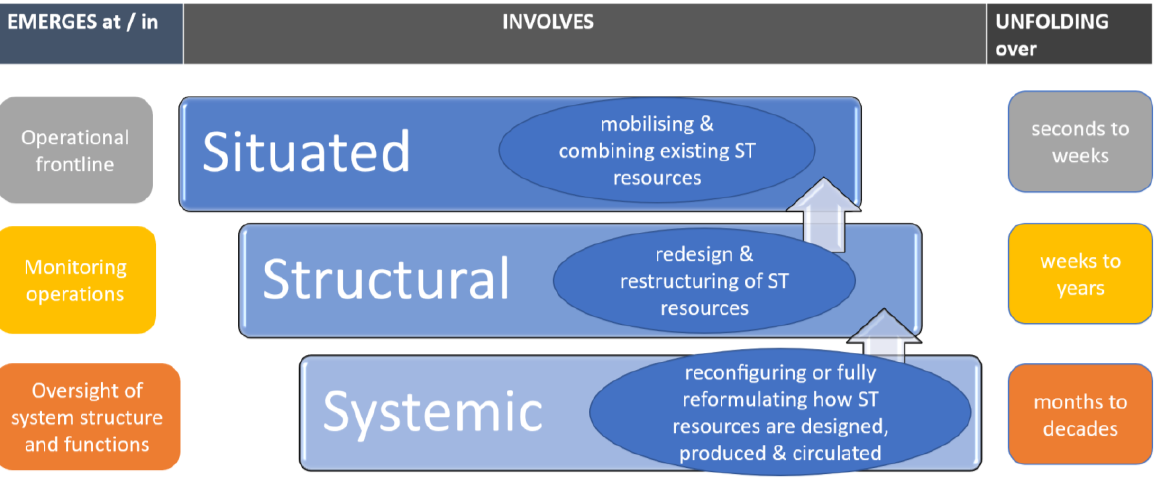
Figure 3. Moments of Resilience (adapted from [15]).